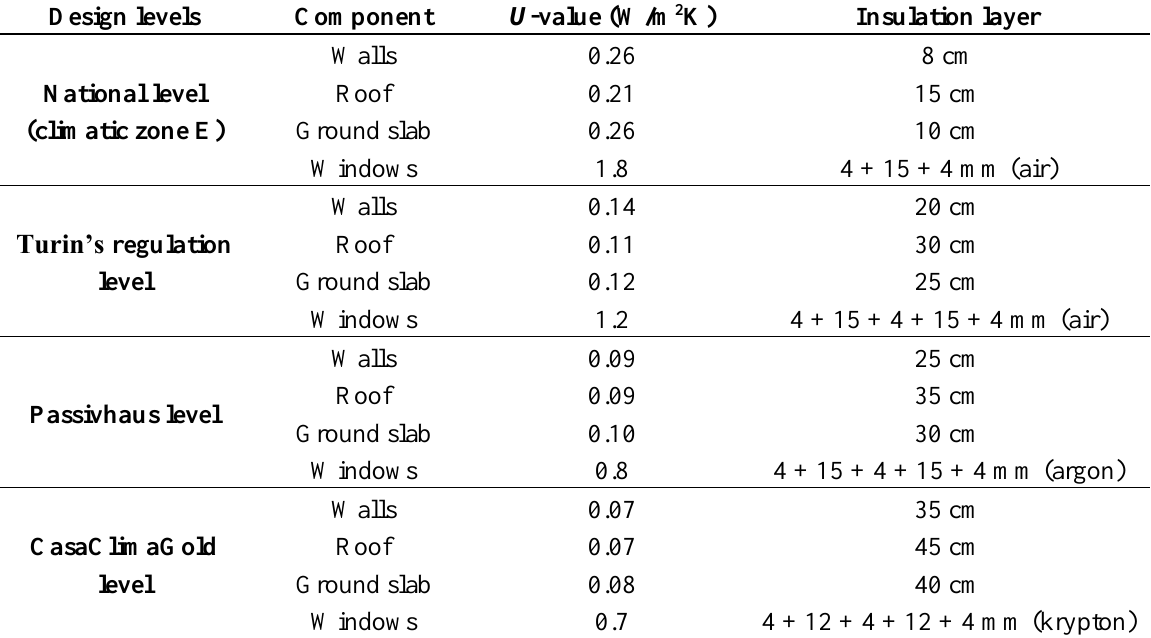
Table 1. Design configurations for the building